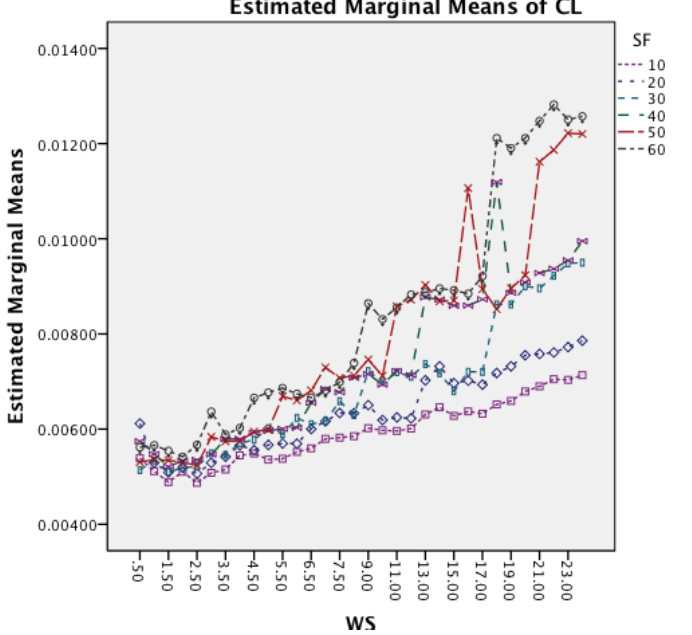
Figure 15. Two-way interaction effect for WS and